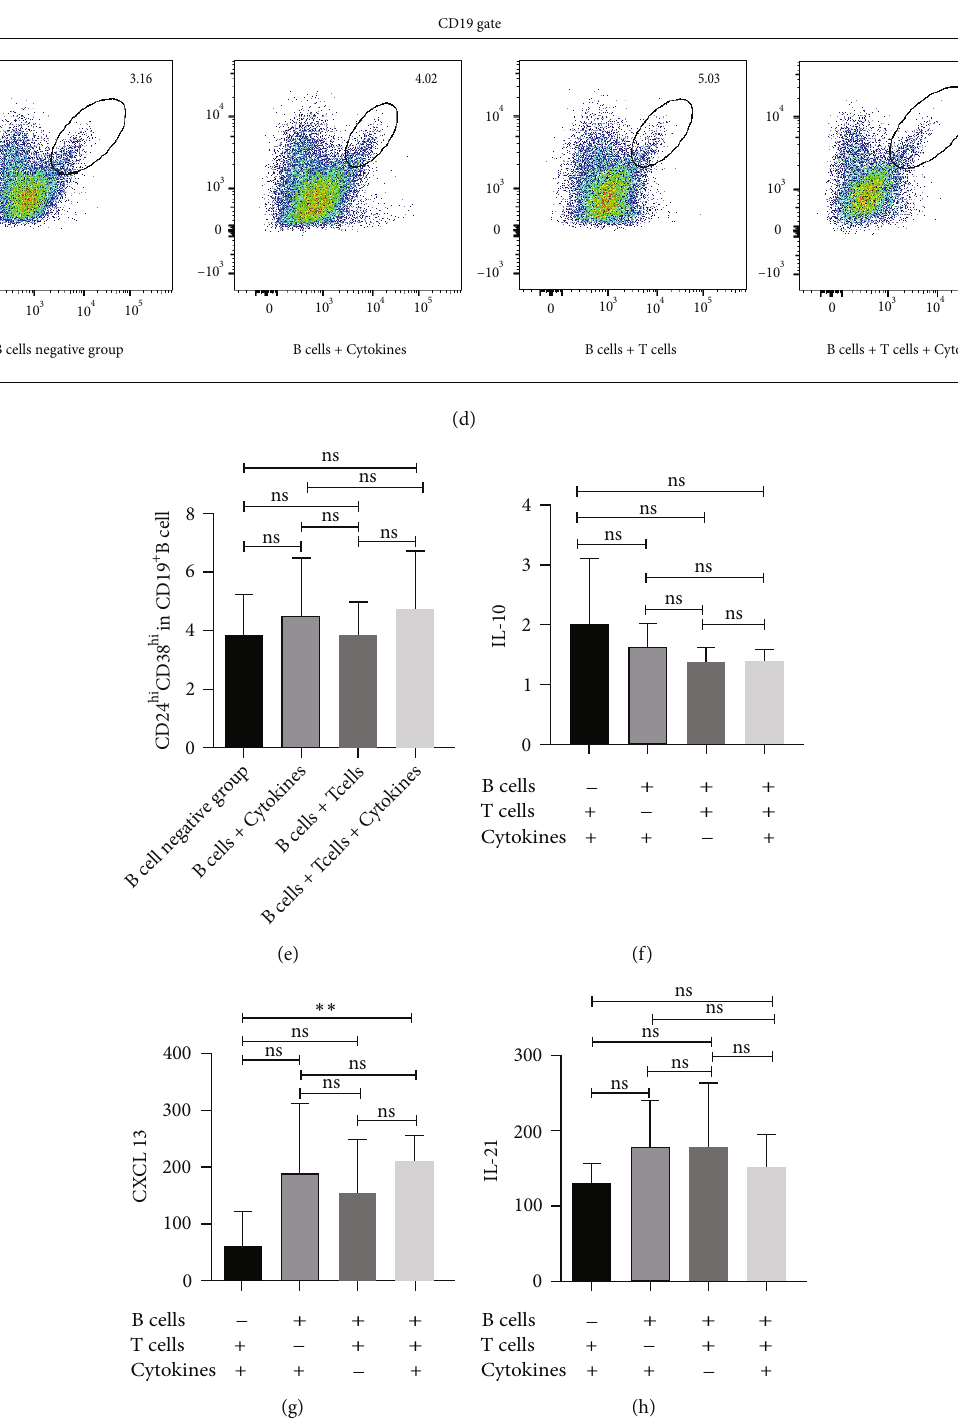
Figure 1: B cell facilitate Tfh cell di ff erentiation and CXCL13 secretion in vitro. Purchased T cells and B cells were obtained from venous blood of healthy people. Tfh cells were stimulated with cytokines and with or without B cell cocultured (a). Tfh cells ’ gate (b) and its percentage variation in the coculture groups (c). Breg cells ’ gate (d) and its percentage variation in the coculture groups (e). The level of IL-10 (f), CXCL13 (g), and IL-21 (h) in the coculture groups. Tfh: follicular help T cells; Breg: regulatory B cells; IL-10: interleukin-10; CXCL13: C-X-C motif chemokine ligand 13; IL-21: interleukin-21; ∗ : < 0.05; ∗∗ : < 0.01; ns: no signi fi